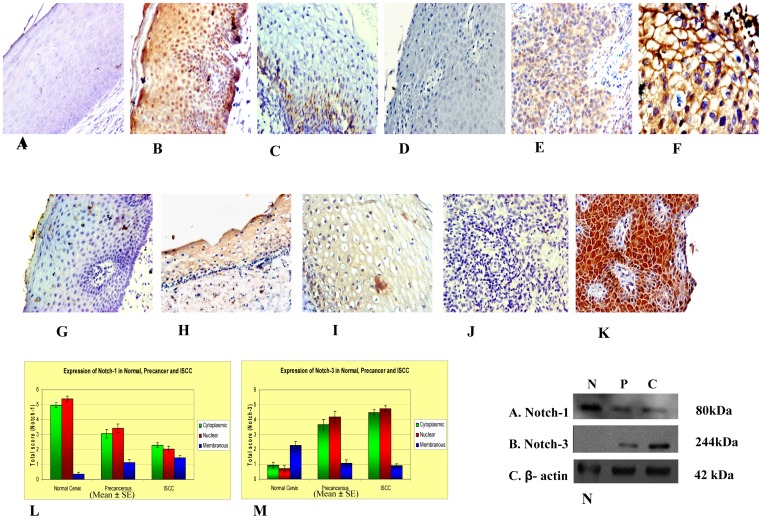
Immuno-histochemical analysis of Notch-1 and Notch-3 showing expression pattern of Notch-1 and Notch-3 in normal, precancerous and cancer tissues of uterine cervix.(A) Negative control of Notch-1 in normal tissue, 200X. (B) Intense nuclear, cytoplasmic expression and loss of membranous expression of Notch-1 in normal cervix, 200X. (C) Moderate nuclear expression of Notch-1 in precancrous tissue, 200X. (D) Negative control (ISCC, 200X). (E) Mild cytoplasmic localization and loss of nuclear Notch-1 in ISCC, 200X. (F) Membranous positive and loss of nuclear expression of Notch-1 in ISCC, 400X. (G) Negative control of Notch-3, 200X. (H) Cytoplasmic localization and loss of nuclear Notch-3 in normal cervix, 200X. (I) Cytoplasmic and nuclear localization of Notch-3 in precancer, 200X. (J) Negative control of Notch-3 (ISCC, 200X). (K) Cytoplasmic and Nuclear localization And loss of membranous Notch-3 in ISCC, 200X as indicated in Materials and Methods section. (L, M) Bar graph showing distribution of total scores of Notch-1 and Notch-3 protein in Normal cervix, Precancer and Invasive squamous cervical carcinoma (ISCC) tissues. The vertical axis shows the total Immunostaining score (cytoplasmic or nuclear respectively), obtained as described in the Methods section. (N) Western blots showing expression pattern of Notch-1 and Notch-3 protein during the progression of cervical cancer. Protein extracts from cervical tumor biopsies as well as normal tissues were separated in 10% SDS-PAGE and detected by specific antibodies of Notch-1 and Notch-3 protein. All the blots were stripped and reprobed for β-actin levels to confirm equal loading and the quantitation of bands was performed densitometrically as indicated in Materials and Methods section.